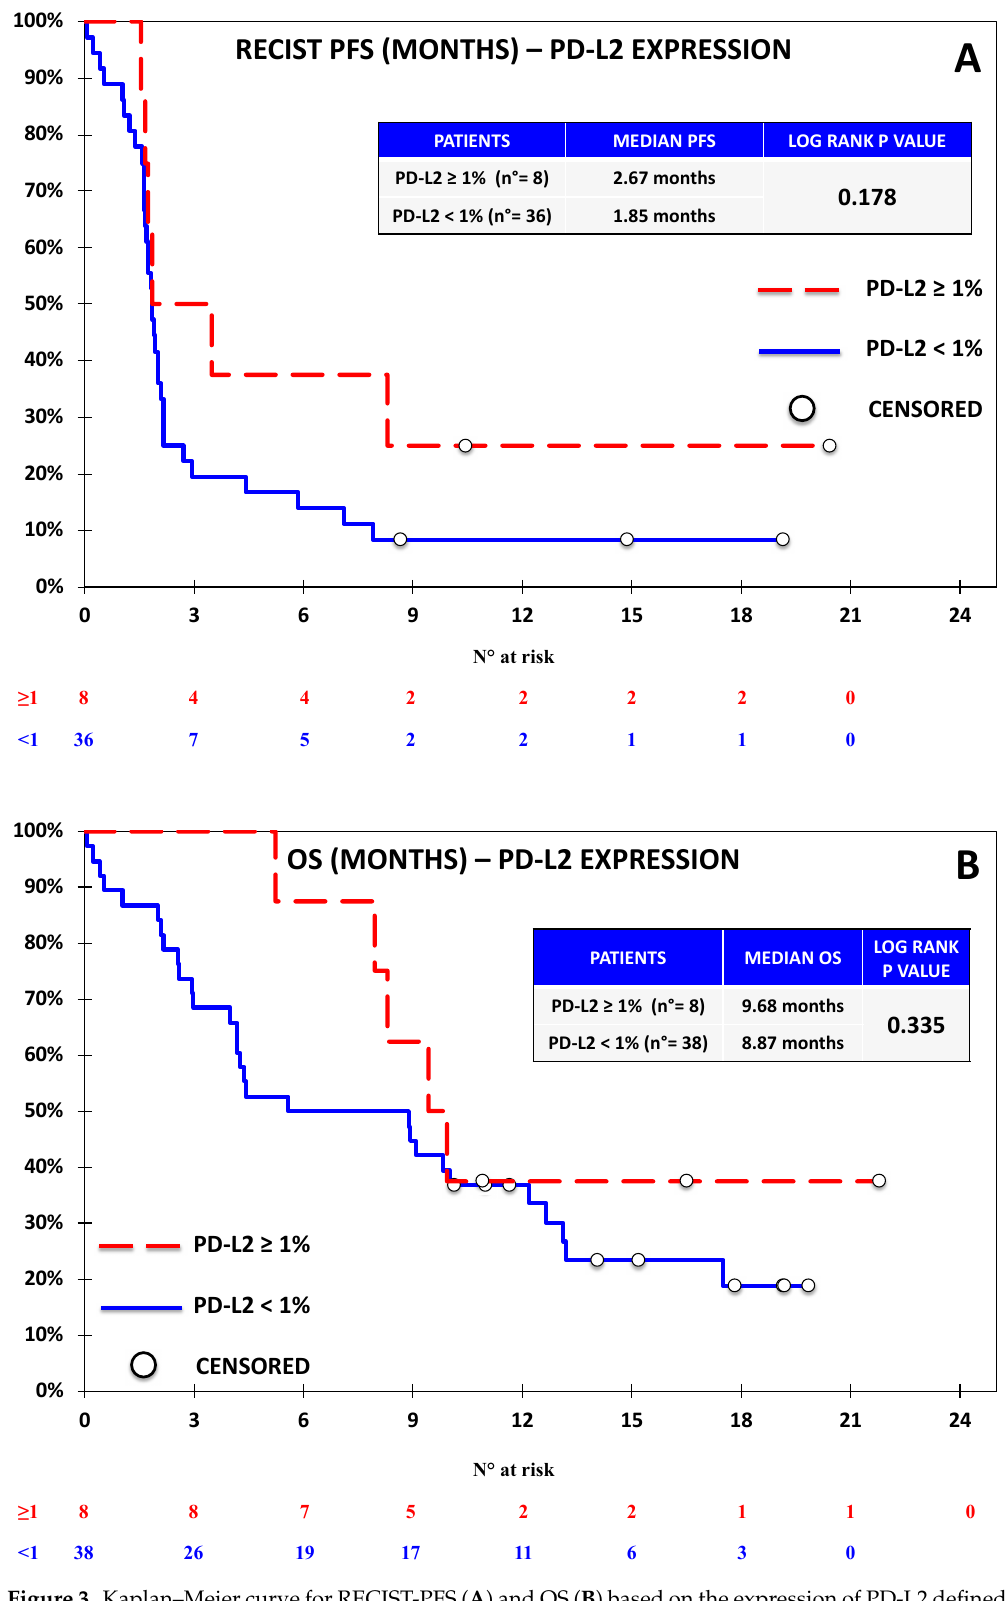
Figure 3. Kaplan–Meier curve for RECIST-PFS ( A ) and OS ( B ) based on the expression of PD-L2 defined as ≥ 1% vs. <1% in the Nivolumab Cohort. No significant difference was observed on the basis of PD-L2 expression.